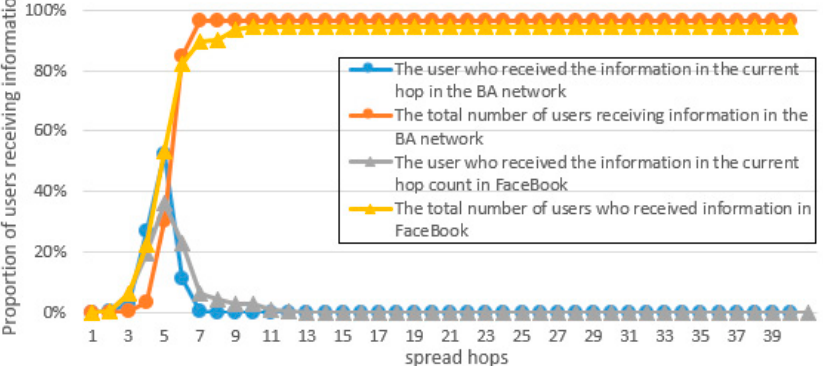
Figure 11. The dissemination process of the privacy information of middle popularity users on the BA network and the Facebook network.